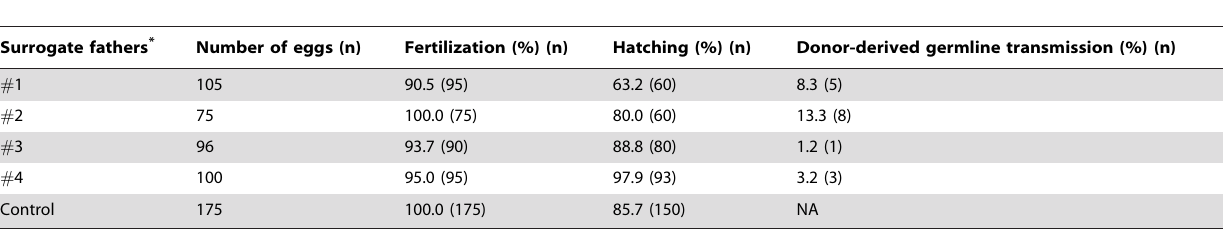
Table 1. Results of artificial insemination of O. bonariensis eggs with sperm derived from surrogate O. hatcheri fathers transplanted with O. bonariensis (donor) germ